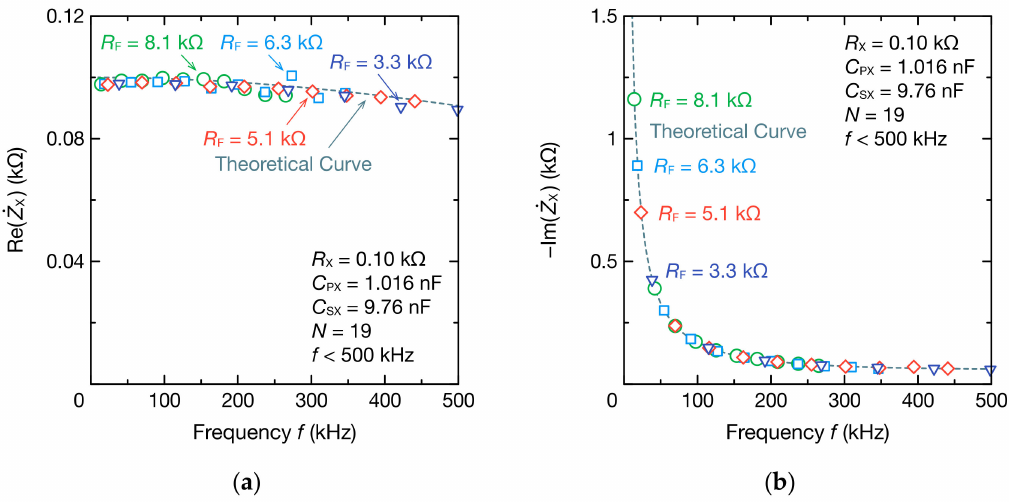
(cid:17) (cid:16) . Z X and ( b ) imaginary part Im